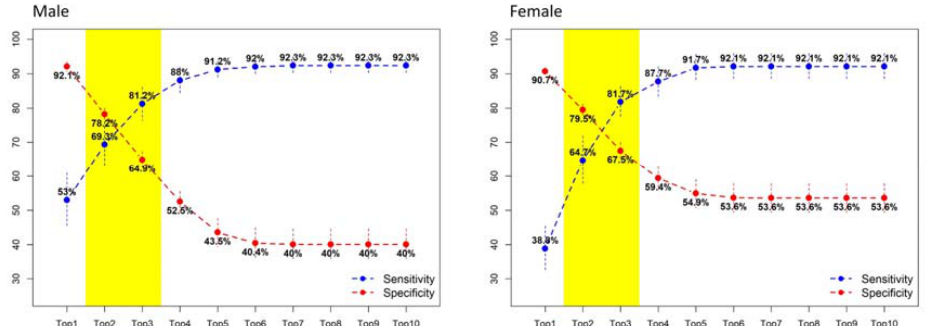
Figure 2. Organ system algorithm for localizing tissue origin. For the cases predicted with non-low risk scores, a k ‐ nearest neighbor based organ system algorithm was used for localizing tissue origin. The performance of a different number of origins is evaluated. When only one possible tissue origin (i.e., top 1) is reported, the sensitivity is low, but specificity is high. In contrast, the sensitivity increases, and specificity decreases when more possible tissue origins (e.g., top 10) are reported. A balanced sensitivity and specificity of the algorithm can be achieved when the top three possible organ systems are reported.